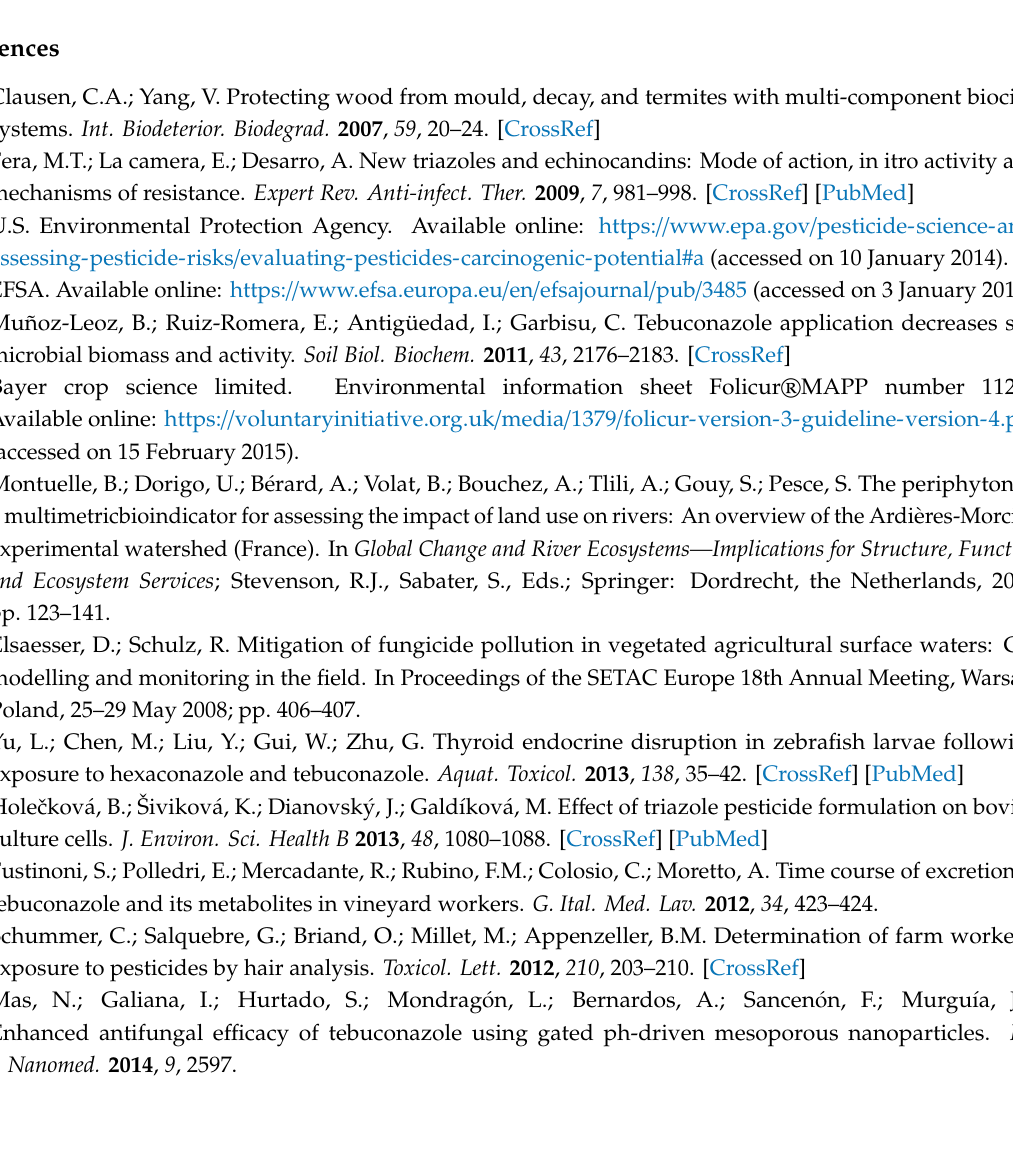
Supplementary Materials: The Supplementary Materials are available online. Figure S1: DSC curves of HSA, Figure S2: Absorption spectra of TB, Figure S3: Hill plots of TB quenching e ff ect on HSA fluorescence at the di ff erent temperatures, Figure S4: Van (cid:48) t Ho ff plot for the interaction between TB and HSA, Figure S5: Synchronous fluorescence spectra of HSA, Figure S6: E ff ect of site marker KTF to the TB / HSA system, Figure S7: E ff ect of site marker IBF to the TB / HSA system, Figure S8: CD spectra of HSA and TB / HAS, Figure S9: Electrostatic potential of the ligand binding pocket in site II, Table S1: Association constants of competitive experiments for the interaction between TB and HAS, Table S2: Peak position and intensity of fluorescence parameters for the interaction between HSA and